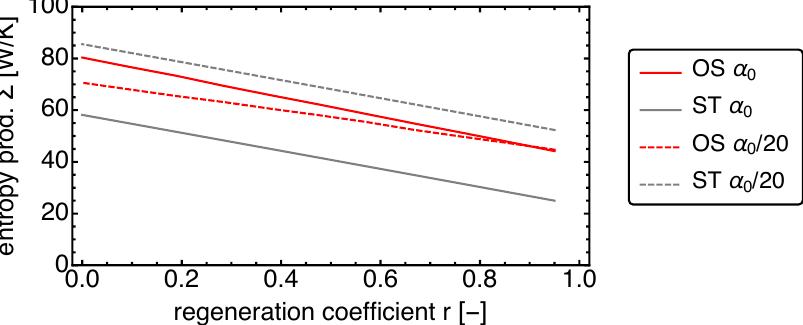
Figure 8. The cycle averaged entropy production rate is shown as a function of the regeneration coefficient r for the reference case in comparison with the low mass transfer case . For both cases the entropy production increases considerably with weaker regeneration.